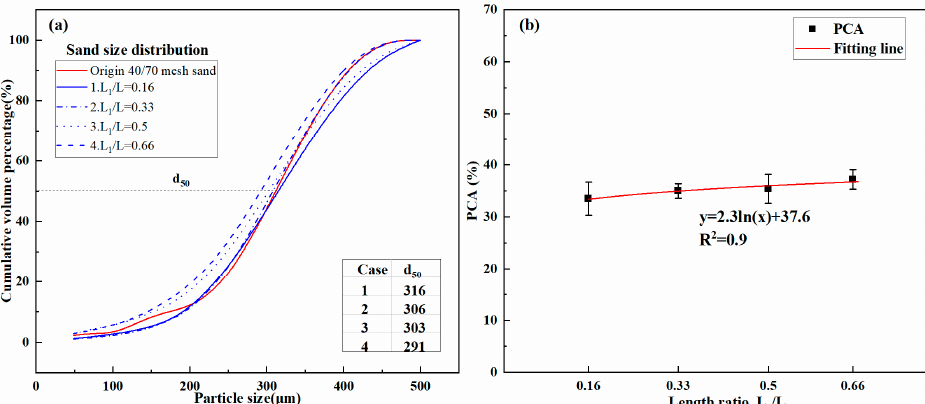
Figure 11. Effect of the distance ratio on the particle dune distribution: ( a ) The particle size distribu- tions of sands flowed out the channel at the injection time = 180 s; ( b ) The PCA in four channels with different distance ratios.